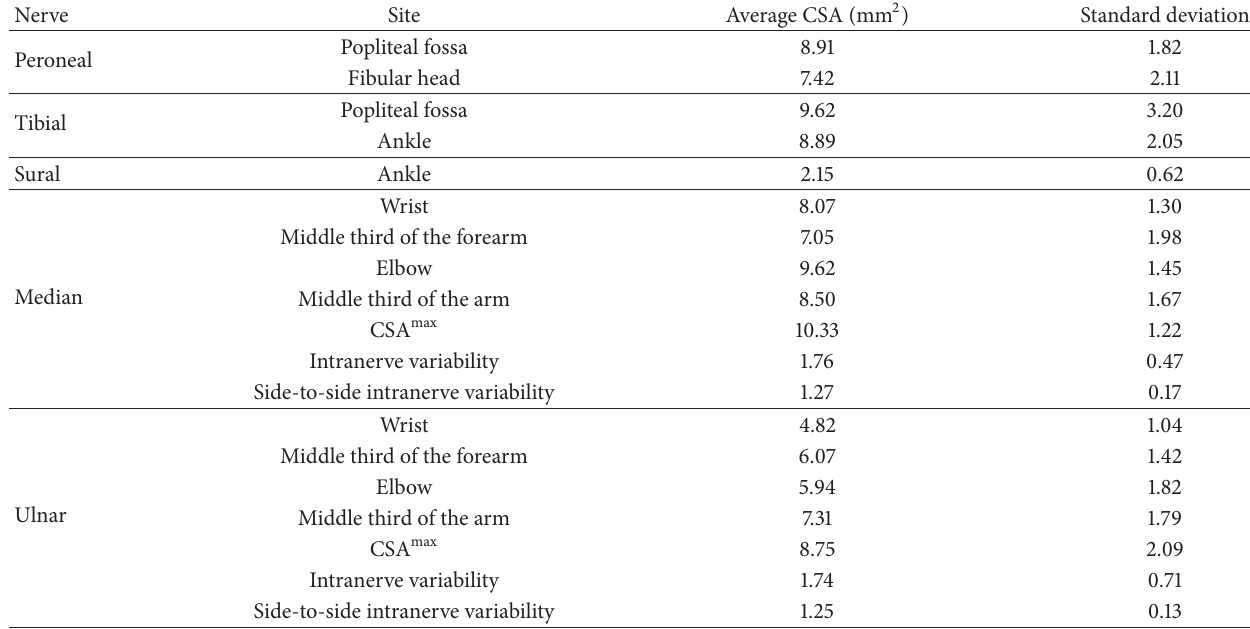
Table 1: Control group ultrasonographic data (70